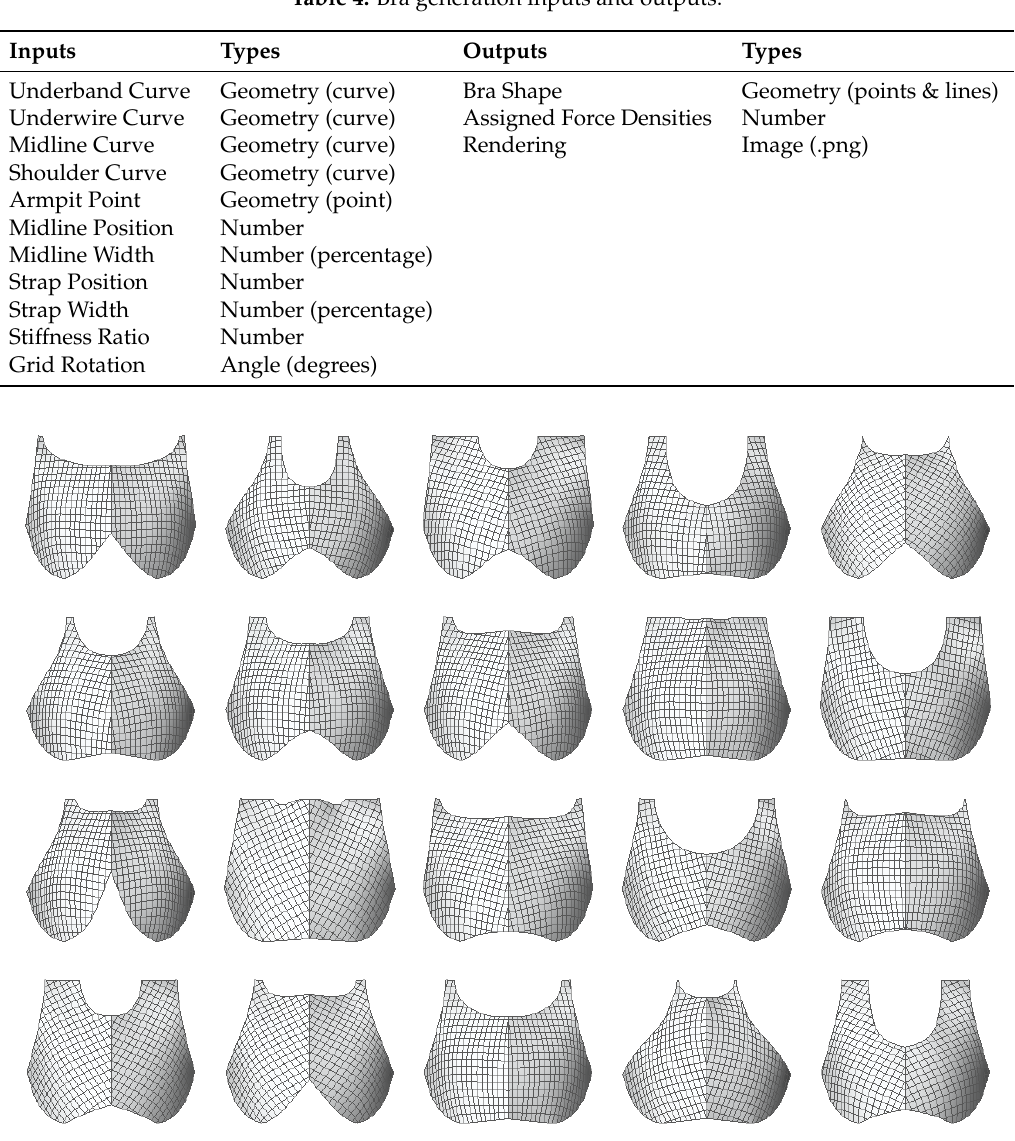
Figure 12. Sampling of generated